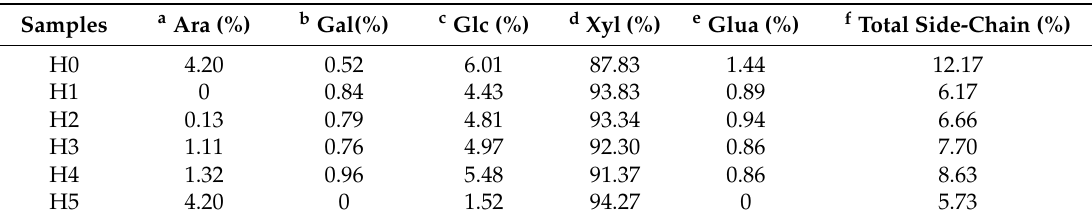
Table 4. The content of neutral sugars (relative % dry weight) and uronic acid (relative % dry weight) in the hemicellulosic samples.